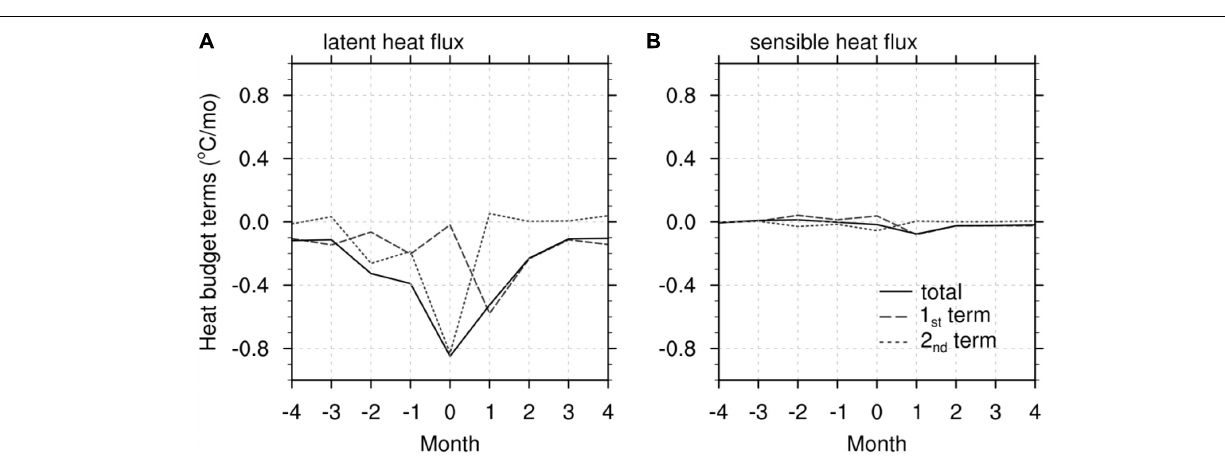
FIGURE 14 | Composite monthly mean heat flux anomaly terms calculated from the mixed layer heat budget equation for the region (110 ◦ E-116 ◦ E, 22 ◦ S-32 ◦ S): (A) latent heat flux, (B) sensible heat flux. First and second terms on the RHS of Eq. (1) are compared. Only the results from CFSR are shown. The first term represents a temperature tendency produced by the flux anomaly with the climatological MLD, and the second term represents a temperature tendency produced by climatological fluxes and the MLD